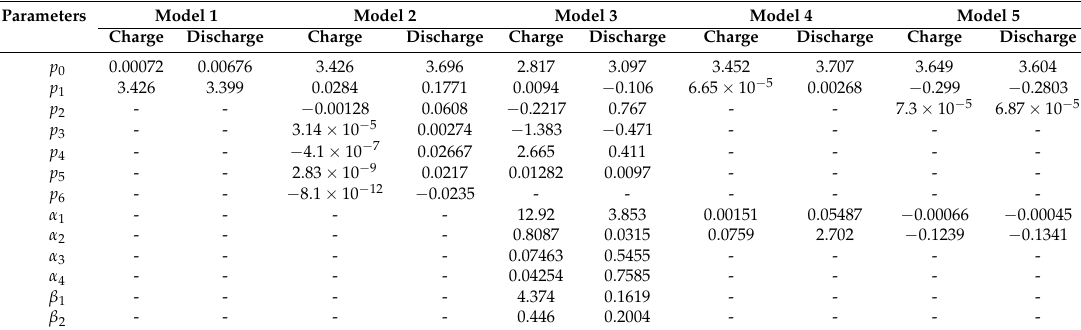
Table 5. The parameters of the fitted OCV models.